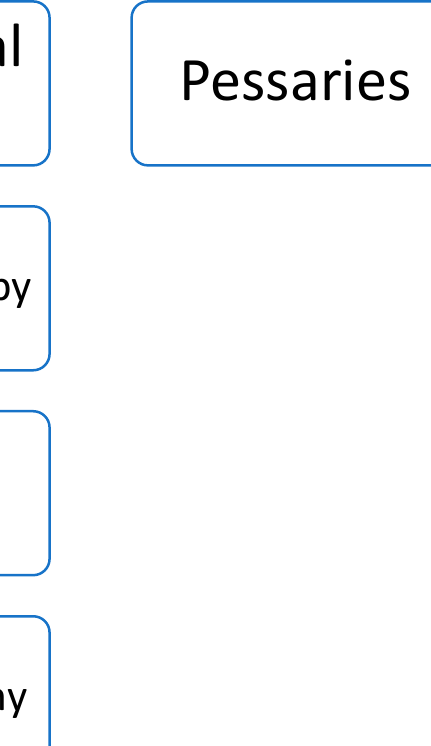
Table 2. The characteristics of the studies on the effectiveness of reconstructive vaginal surgeries by native tissue on the quality of life in women with pelvic organ prolapse.